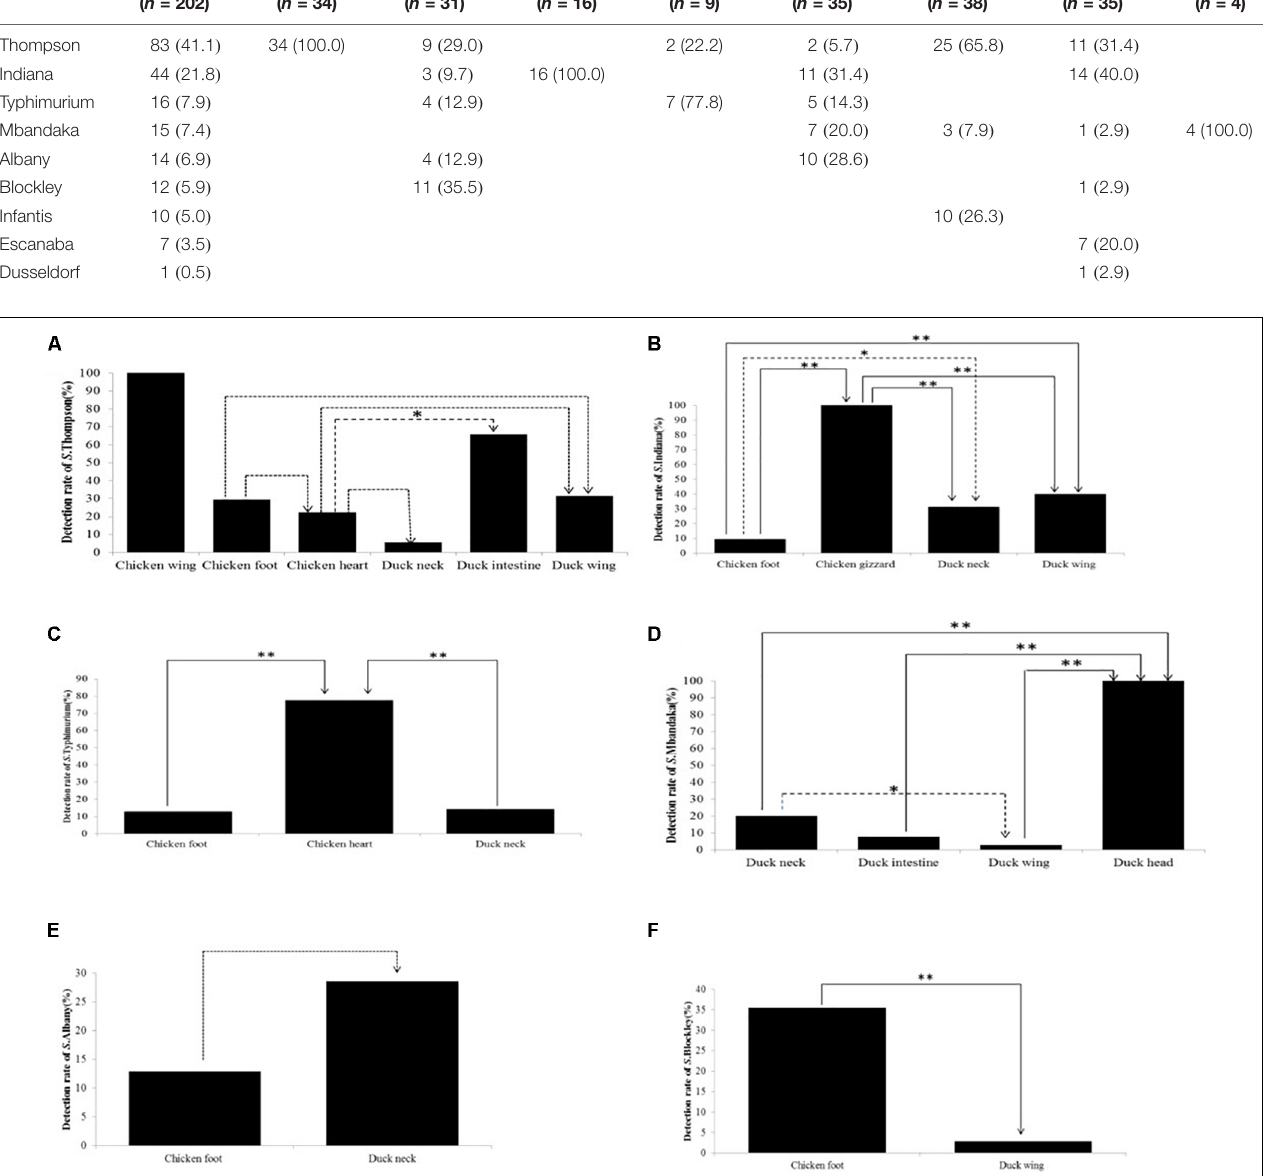
FIGURE 1 | Detection rates of non-typhoidal Salmonella strains among the six most common serotypes in different types of Salmonella- positive samples from pickled ready-to-eat meats (PRTEMs). (A) S . Thompson; (B) S . Indiana (C) S. Typhimurium; (D) S . Mandaka; (E) S . Albany; (F) S . Blockley. ∗∗ P < 0.01; ∗ P < 0.05.